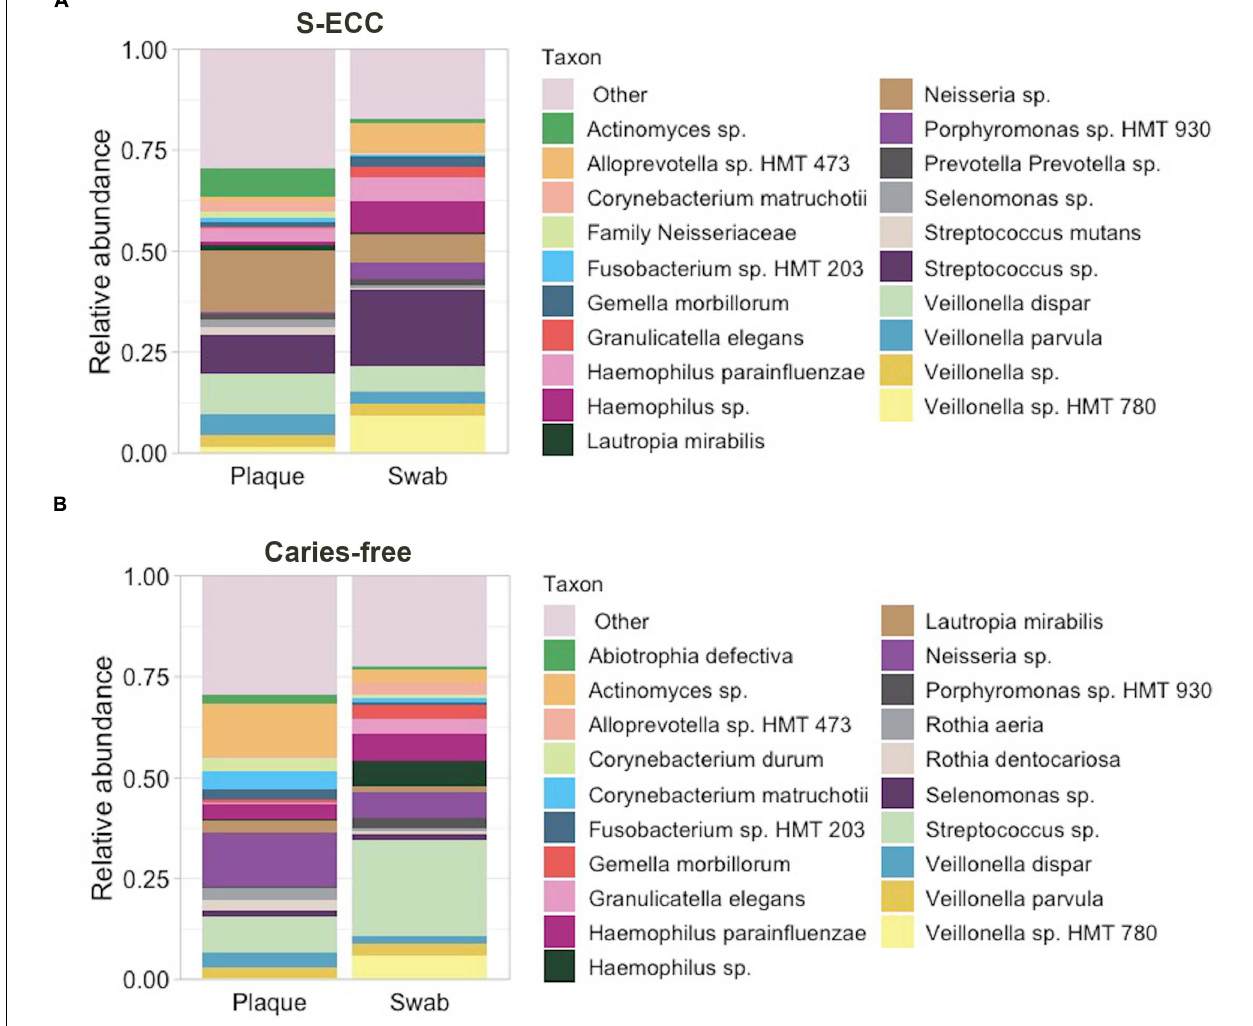
Frontiers in Microbiology |